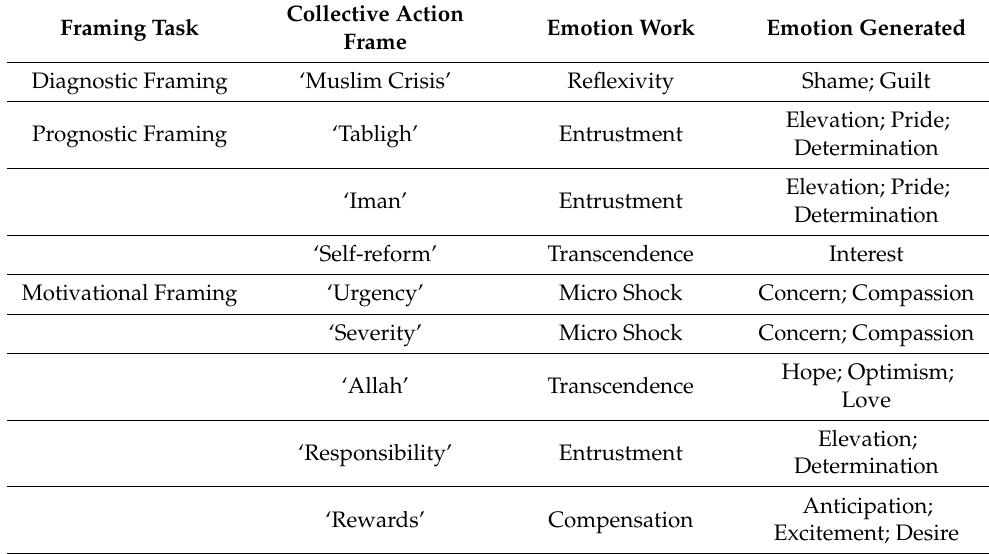
Table 1. Tabligh Jama’at Framing, Emotion Work, and